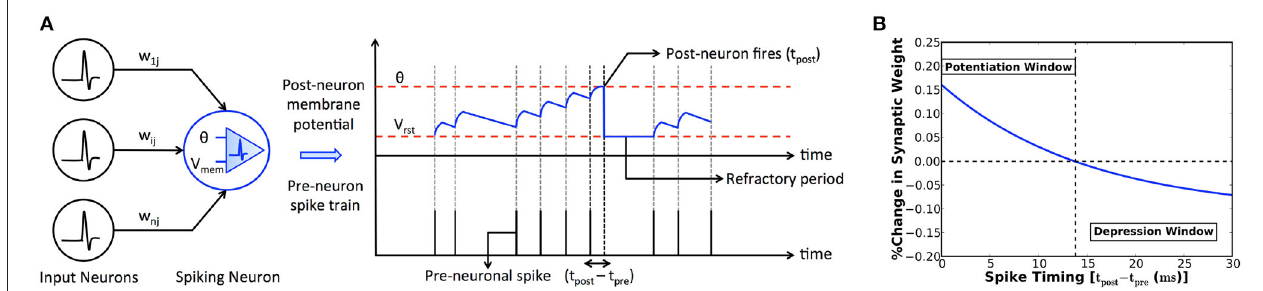
FIGURE 1 | (A) SNN consisting of input (pre) neurons connected by weighted synapses ( w ij ) to a spiking (post) neuron. The input spikes are modulated by the synaptic weights to produce resultant post-synaptic current that leaks exponentially in the time interval between successive input spikes. The spiking neuron integrates the post-synaptic current into its membrane potential ( V mem ) that subsequently decays in an exponential manner. The neuron fires an output spike (at time instant t post ) when its potential exceeds a threshold ( θ ). The potential is subsequently reset (to V rst ) and the neuron is restrained from firing for a certain refractory period. (B) Illustration of the power-law weight-dependent STDP rule formulated in (1) for learning rate ( η ) of 0.005, time constant ( τ ) of 15ms, STDP offset of 0.4, maximum weight ( w max ) of unity, current weight ( w ) of 0.5, and exponential factor ( µ ) of 0.9. The synaptic weight is increased (potentiated) for strong temporal correlation between a pair of pre- and post-neuronal spikes ( t post − t pre ≤ 14 ms for the chosen parameters), and decreased for larger spike time differences.